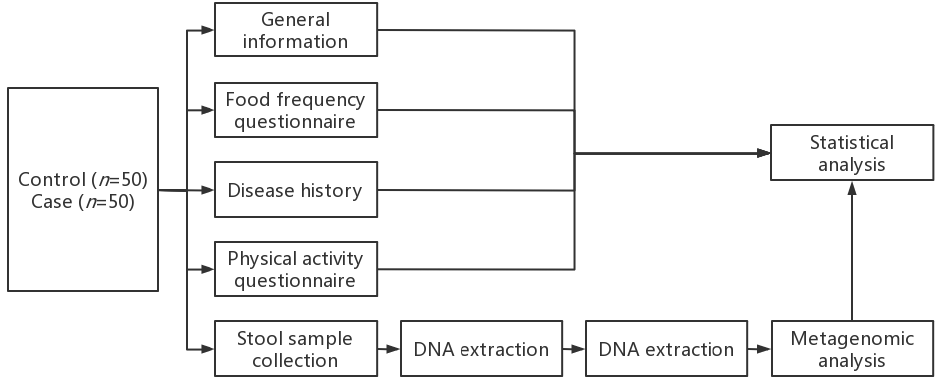
Figure 1. Research flow design chart.